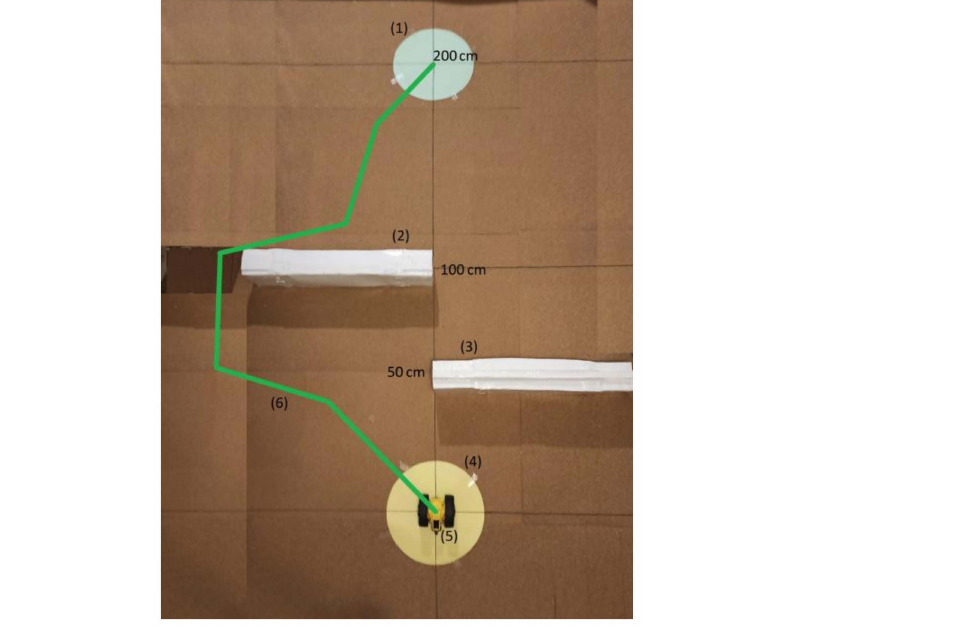
Figure 14. Trajectory in a scenario with two obstacles: (1) goal, (2, 3) obstacles, (4) home, (5) robot, and (6) trajectory.